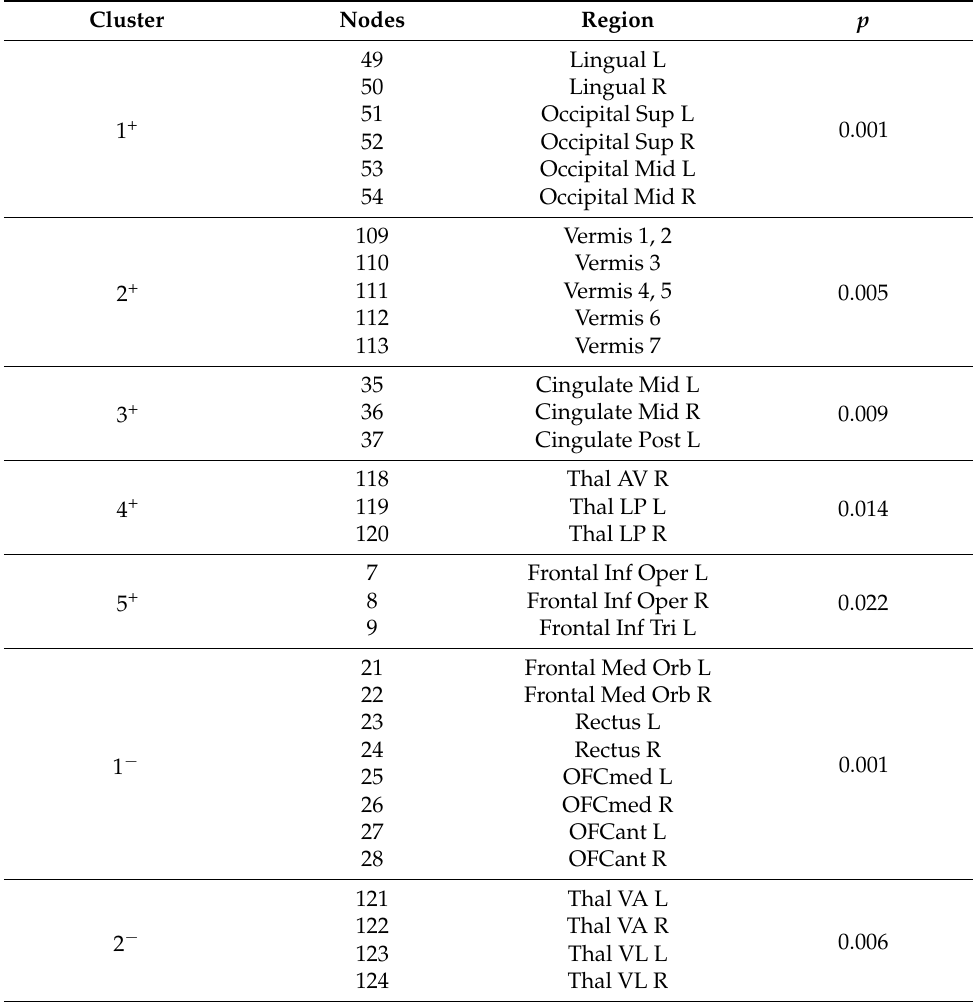
Table 3. Significant clusters for the node eigenvector centrality measure; here, superscripts “+” and “ − ” denote positive (Control > MDE) and negative (MDE > Control) clusters, respectively. Cluster